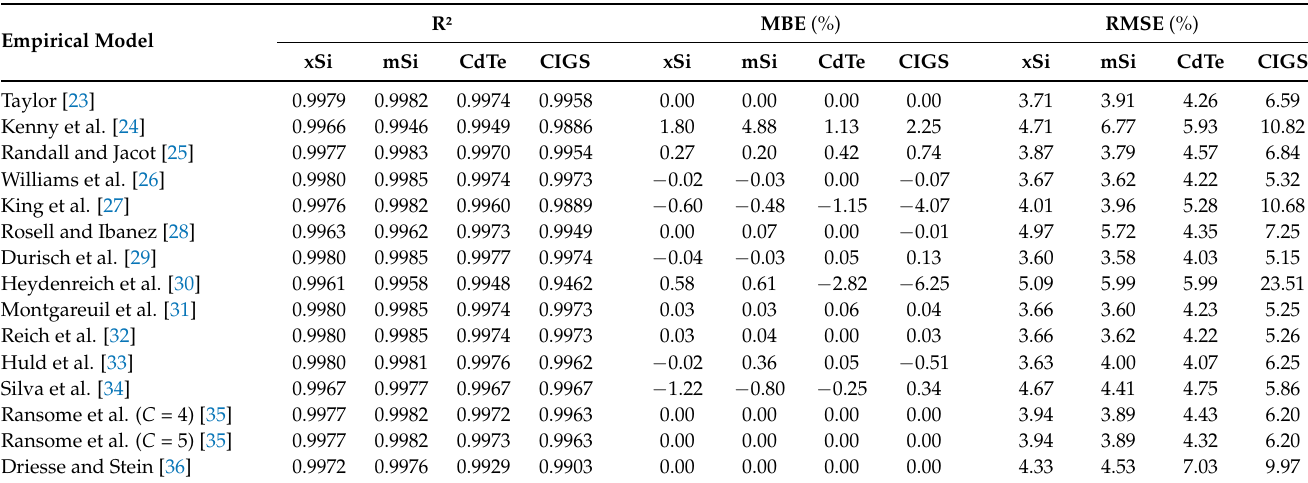
Table 4. Assessment metrics calculated from the results obtained by each empirical model for each PV technology in the study, when they were applied when considering the conventional